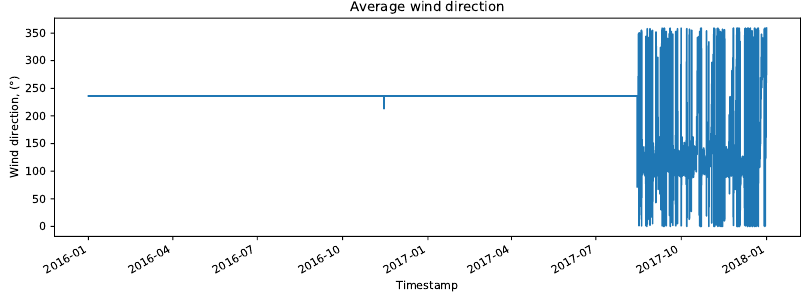
Figure 11. The signal from a broken sensor.